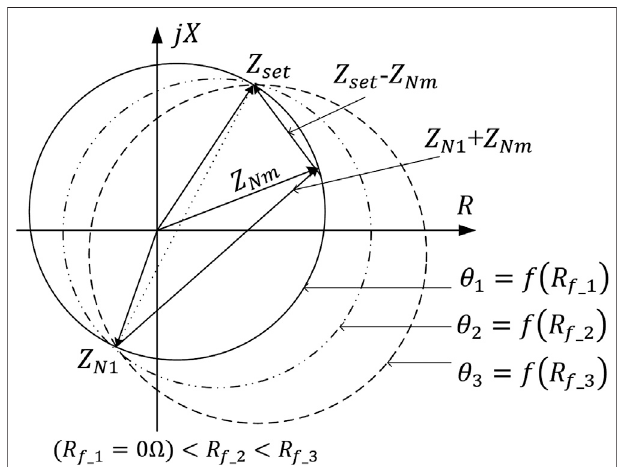
FIGURE 2 | Adaptive characteristics with the fault resistance of positive sequence voltage fault component polarized impedance relay when forward fault occurs.